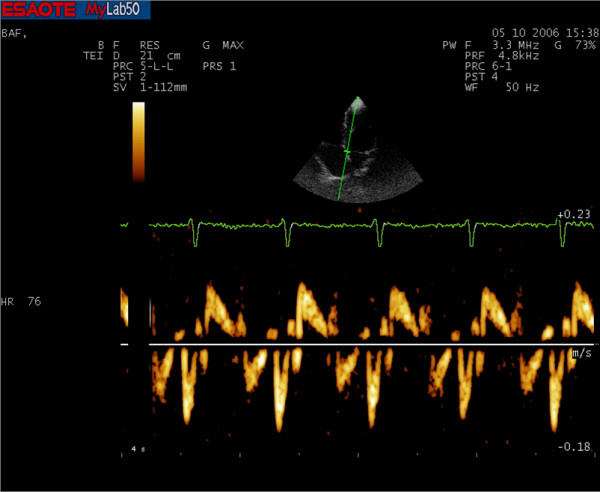
PW-TDI spectrum of an athlete's heart. It is possible already notice a reversal of Em and Am wave velocities than the master athletes.